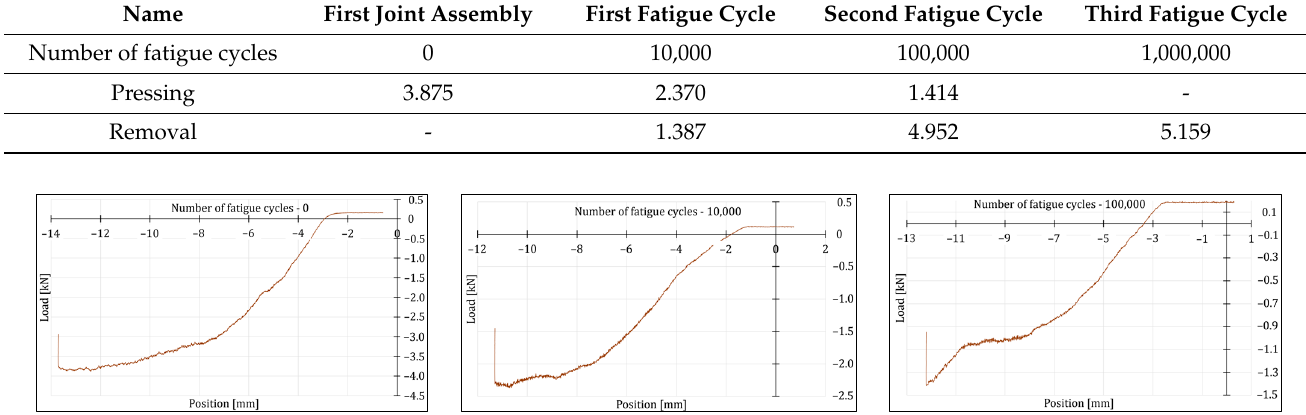
Figure 4. Sleeve pressing force pa tt ern after the successive fatigue cycles.